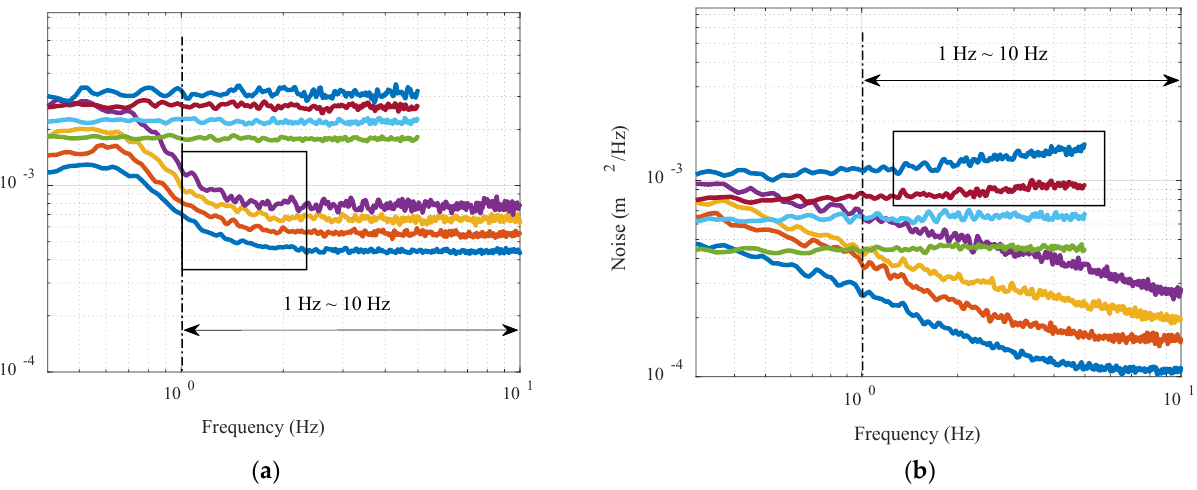
Figure 11. The enlarged average PSD with the frequency range of 1–10 Hz in ( a ) LR and ( b ) HR modes. The legend is the same as in Figure 10.